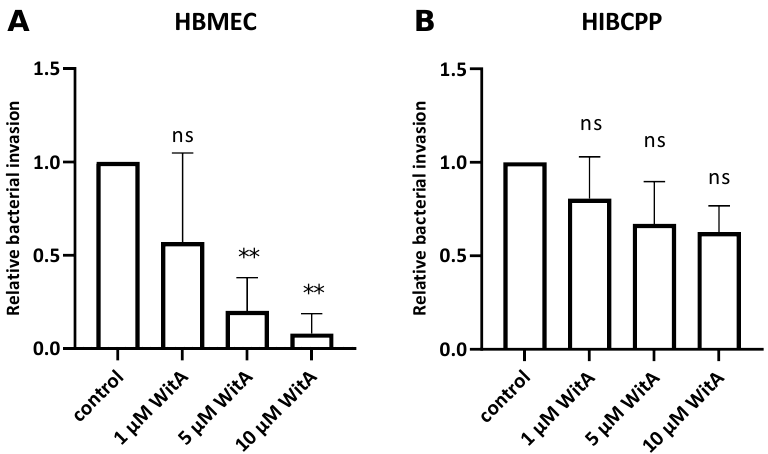
Figure 5. Lm requires surface vimentin for entry into HBMEC. HBMEC grown in chamber slides ( A ) and HIBCPP cells grown in the inverted cell culture filter system ( B ) were pre-incubated with WitA (/, 1 µM, 5 µM or 10 µM) for 0.5 h and subsequently infected with wild-type Lm EGD-e (MOI = 10) and co-incubated for 4 h. Invasion rates were determined using double immunofluorescence mi- croscopy. Shown is the relative bacterial invasion normalized to the untreated control. The results of at least three independent experiments performed at least in duplicate are shown. ** = very significant ( p < 0.01), ns = not significant (significance determined in relation to the invasion of the wild-type bacteria).